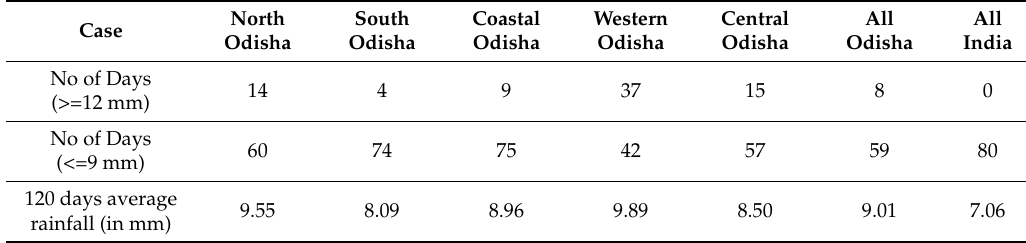
Table 2. Sub-regional scale analysis of rainfall categories in daily climatology over the Odisha State. Case